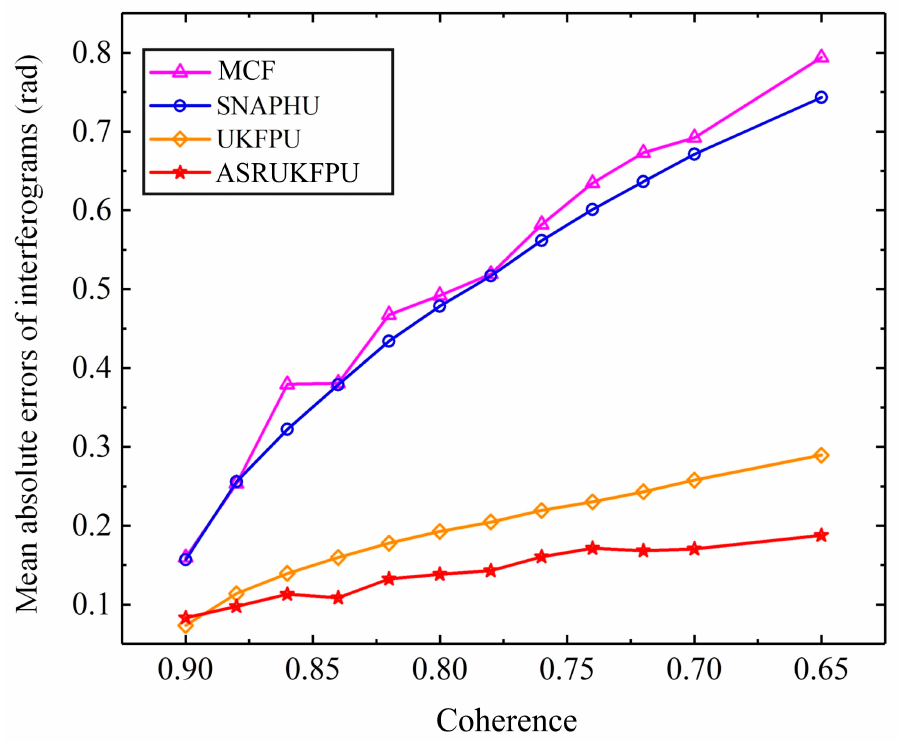
Figure 7. The robustness analysis line graph of different PU methods.